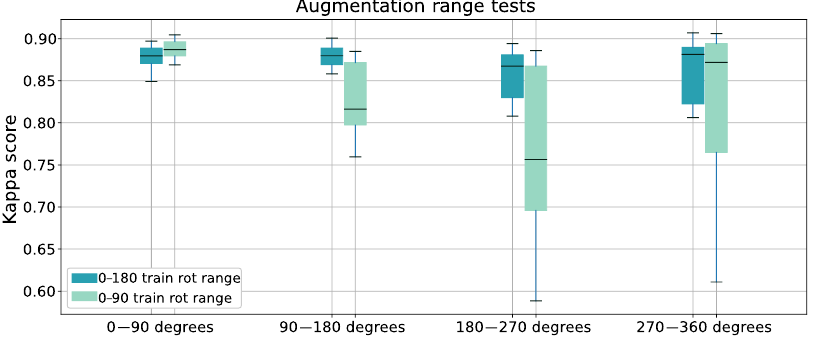
Figure 6. Performances comparison of Kappa score between two differently augmented